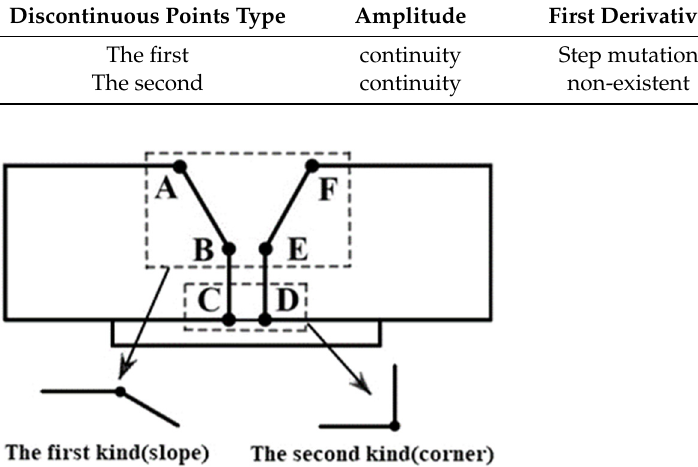
Table 1. Properties of discontinuous points of function.